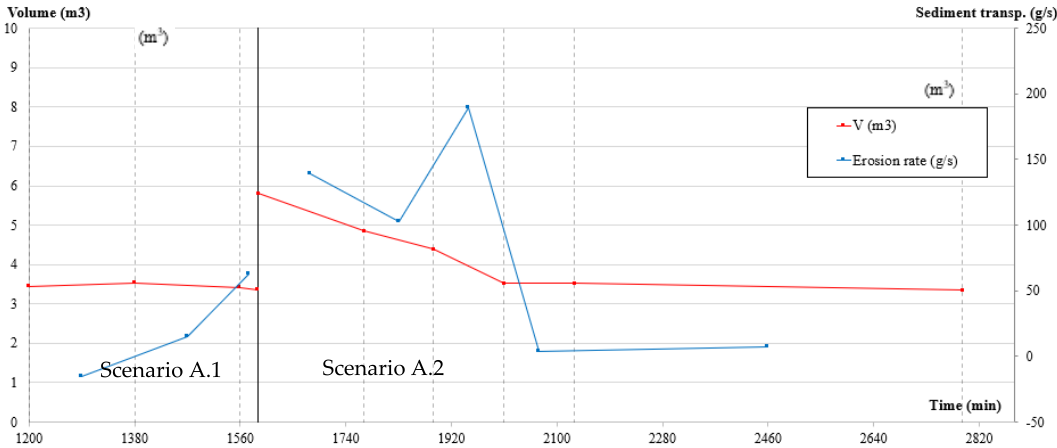
Figure 10. Timeline for beach volume variation and sediment transport volumes rate. Vertical black line represents the transition between scenarios A.1 and A.2. The vertical black dashed lines represent the instants when the equipment was stopped.